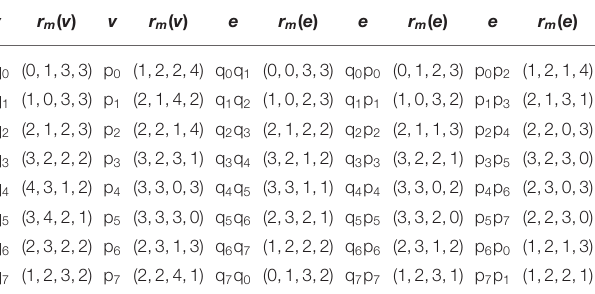
TABLE 1 | Codes for P ( n